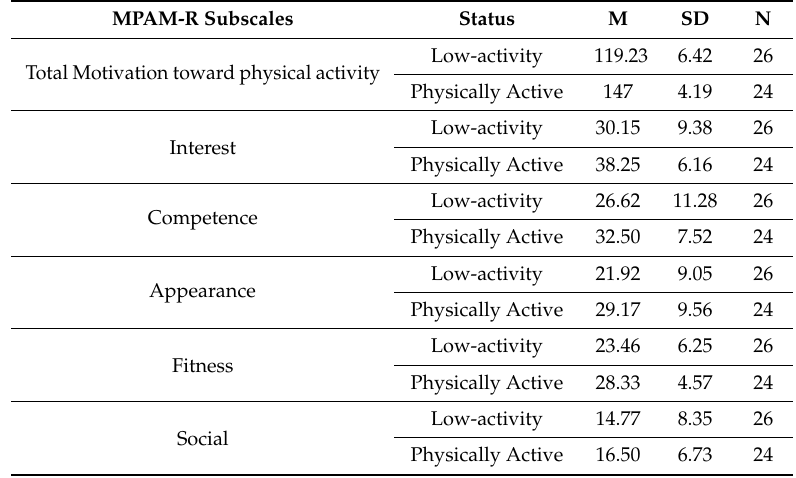
Table 2. Mean and Standard deviation for MPAM-R subscales: total motivation toward physical activity, interest, competence, appearance, fitness and